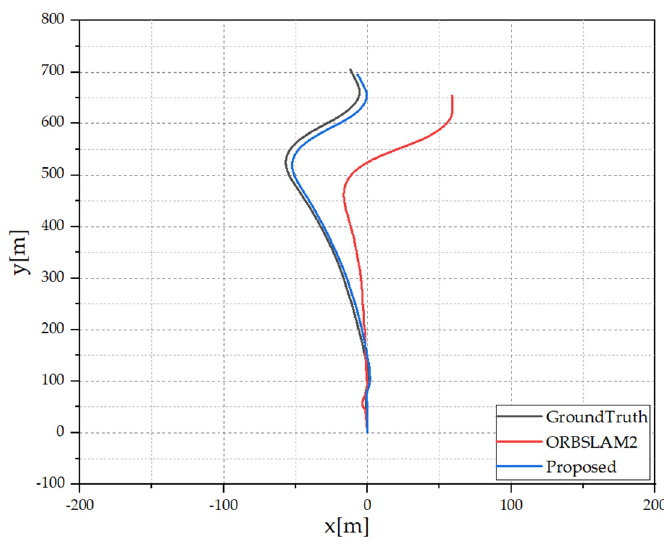
Figure 7. Estimated trajectories of sequence 20 from KITTI Tracking Dataset.